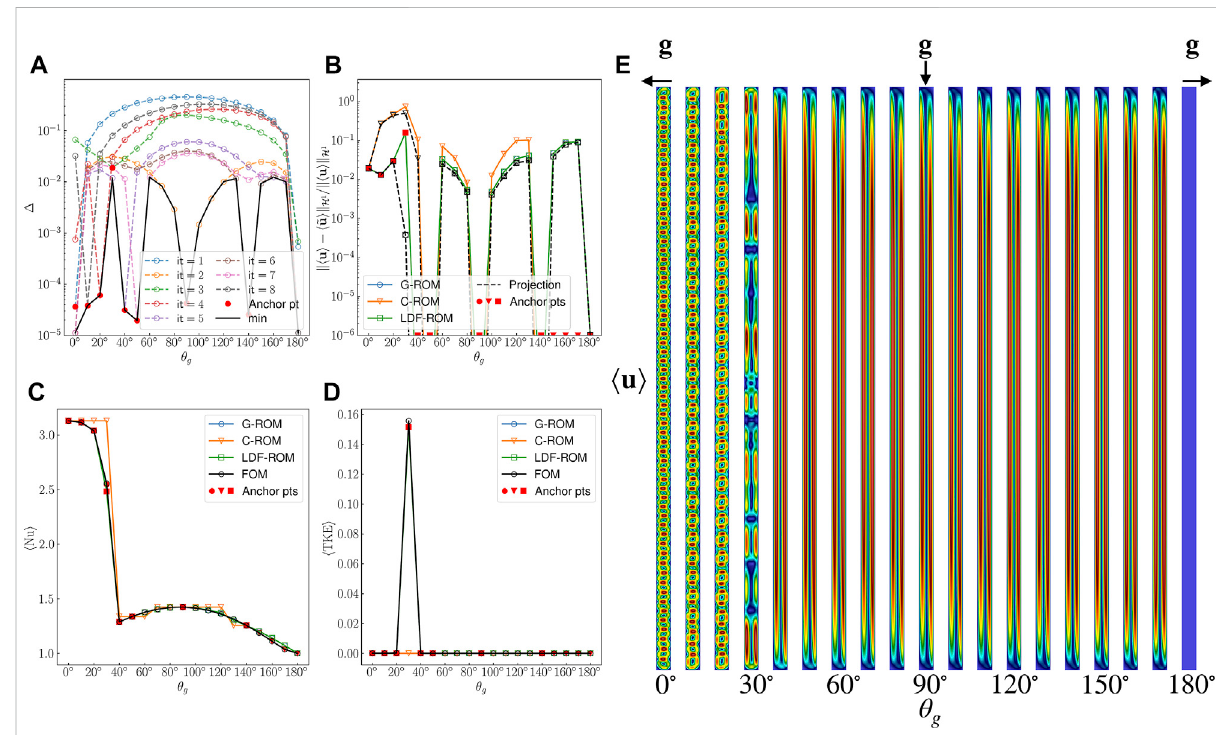
FIGURE 3 POD- h GreedyperformancecomparisonbetweenG-ROM,C-ROMandLDFROMfortheparametricproblemparameterizedwith θ g atRa=1× 10 4 and Pr = 7.2. (A) Behavior of the error indicator Δ de fi ned in Eq. 44 for eight iterations with G-ROM. (B – D) Behavior of the relative H 1 error in predicted solution, mean Nu and mean TKE with θ g based on eight anchor points. ( N = 1 for all θ g ∈ P anchor except N = 70 at θ p g , 3 (cid:1) 30 ° .). (E) Mean (or steady) velocity magnitude for 19 uniformly-spaced θ g ∈ [0 ° , 180 ° ]. (The corresponding temperature solutions are in Figure